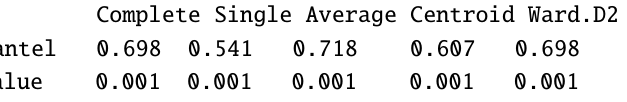
Figure 4. The quality of clustering based on visual assessment of the cluster tendency (VAT).